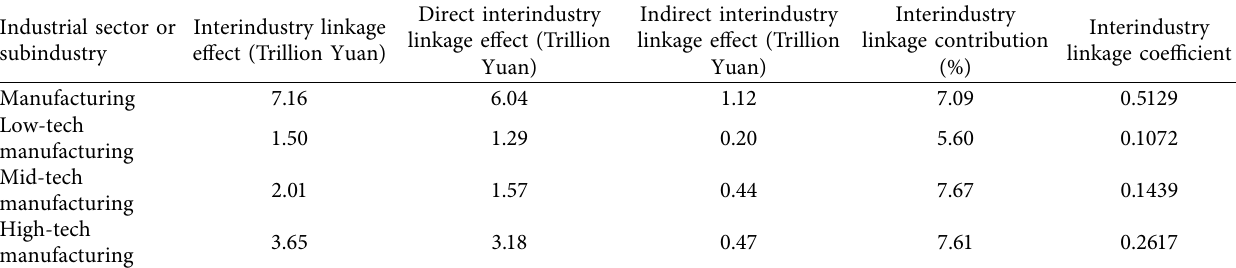
Table 6: Interindustry linkages from producer services to manufacturing and its